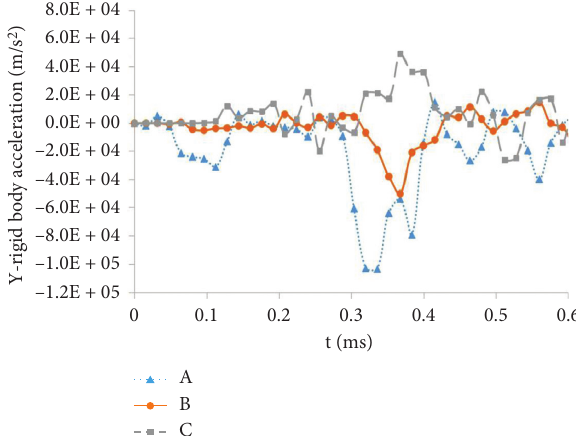
Figure 14: Acceleration curve in the Y -direction at different po- sitions of the missile.